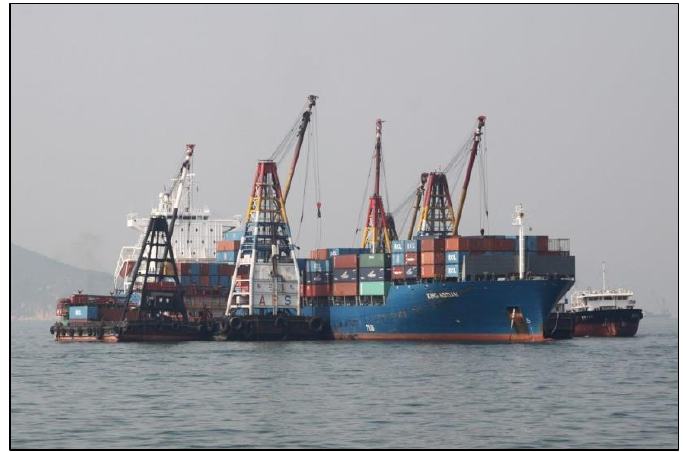
Figure 1: Traditional midstream operation in Hong Kong